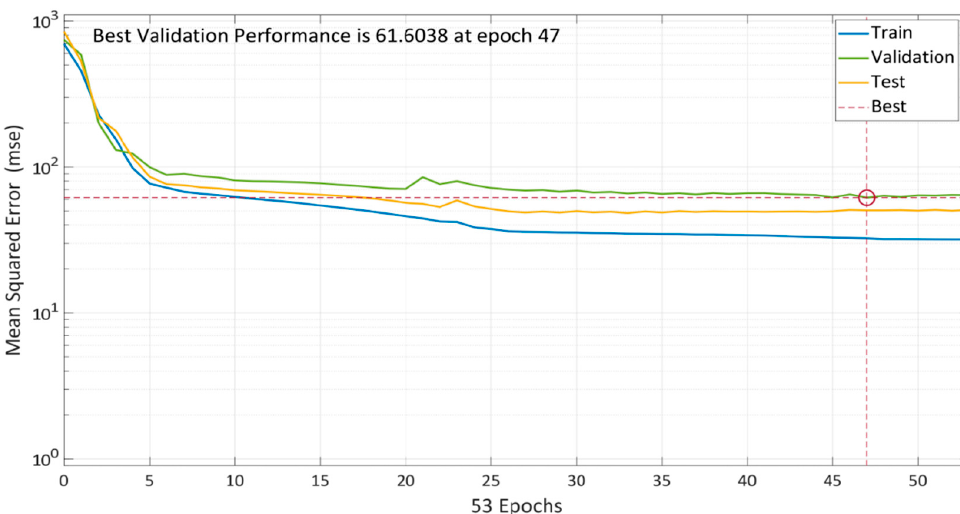
Figure 8. Model performance using LM algorithm.